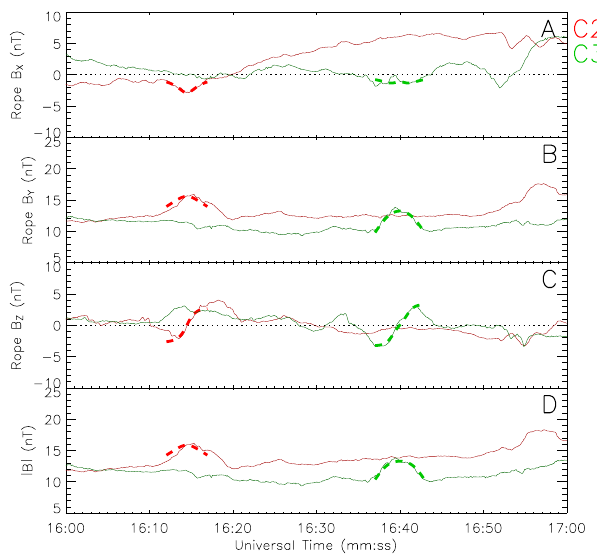
Fig. 6. Model fits for Signature 3. The thick dashed lines represent the model flux ropes, the thinner solid lines the FGM data. Colours as before. Panels (A–C) show the three field components in the flux rope model frame and panel (D) the total field. Data have been offset by –10 and 10s for C2 and C3, respectively.